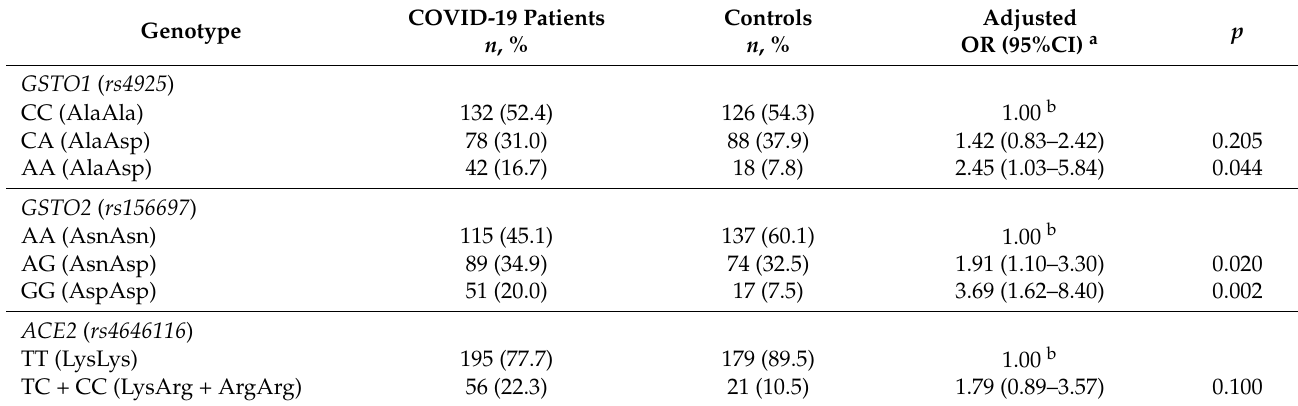
Table 3. The distribution of genotypes among COVID-19 patients and